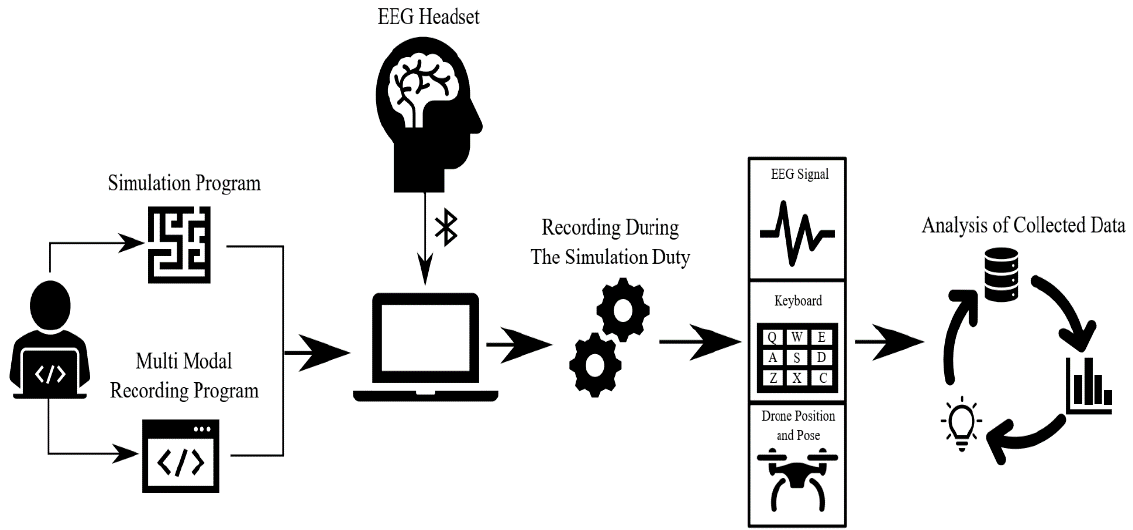
Figure 1. General method flowchart.